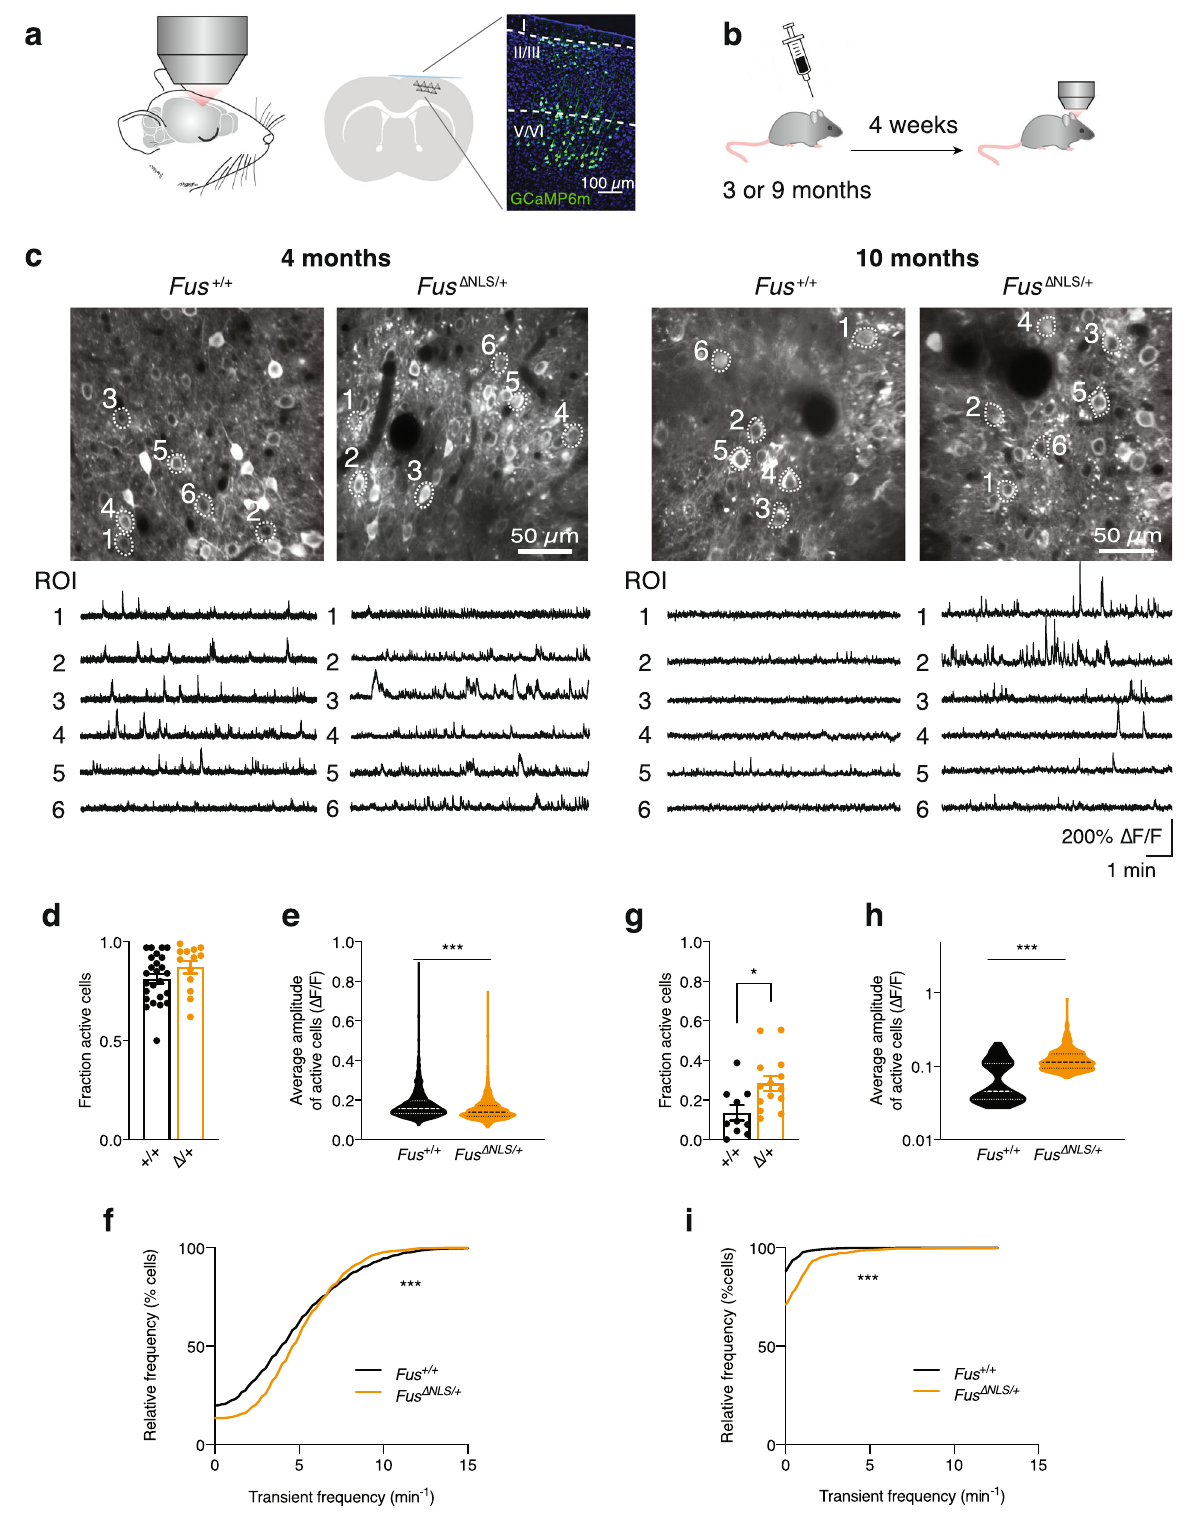
identify two mRNA modules signi fi cantly correlated with the genotype condition in cortex and labeled as turquoise and yellow modules according to the WGCNA conventions (Bonferroni- corrected P < 0.05; Fig. 5a, Supplementary Data 1). Cell-type enrichment analysis demonstrated that the turquoise module, but not the yellow module, was enriched in neuronally expressed